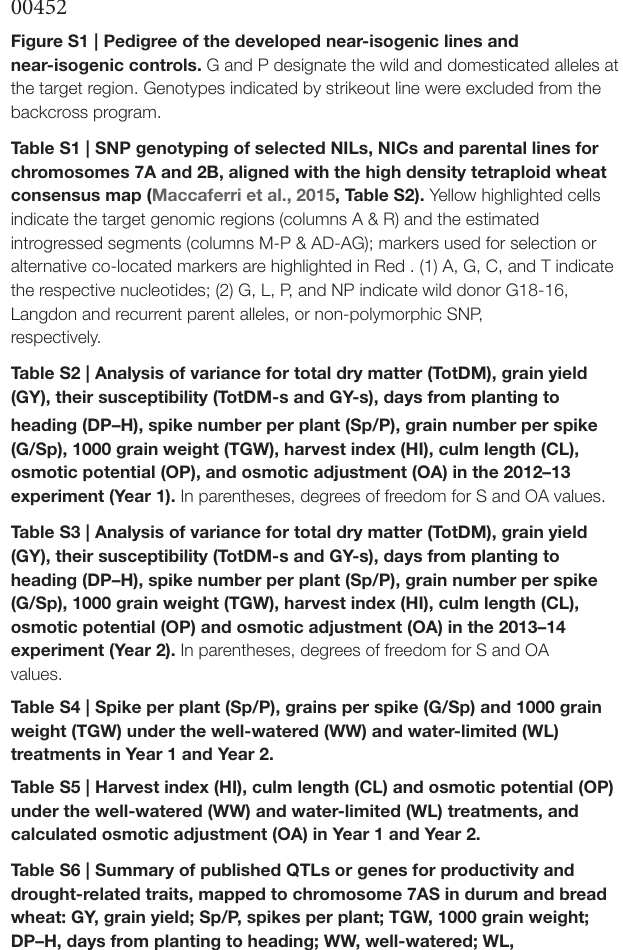
Table S3 | Analysis of variance for total dry matter (TotDM), grain yield (GY), their susceptibility (TotDM-s and GY-s), days from planting to